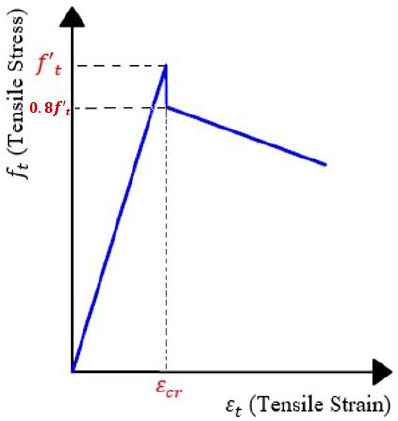
Figure 4. Concrete Compression Post-Peak Response: ( a ) Comparison between Concrete Compres-